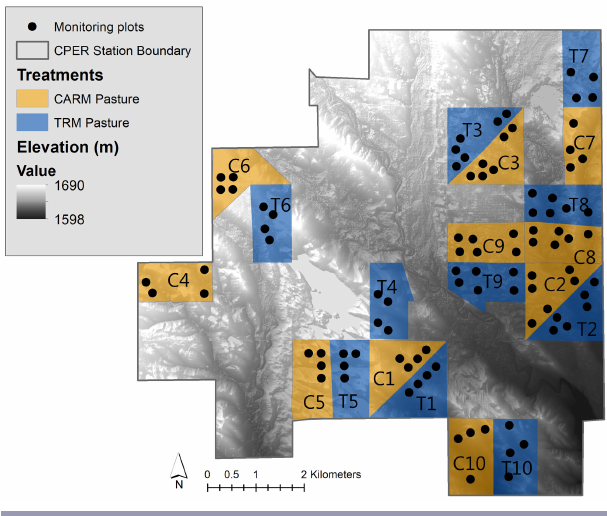
Fig. 2 . Map of the Central Plains Experimental Range (CPER) in northeastern Colorado, showing the distribution of pastures in each of the two treatments in the collaborative adaptive rangeland management (CARM) grazing experiment. TRM = traditionally managed